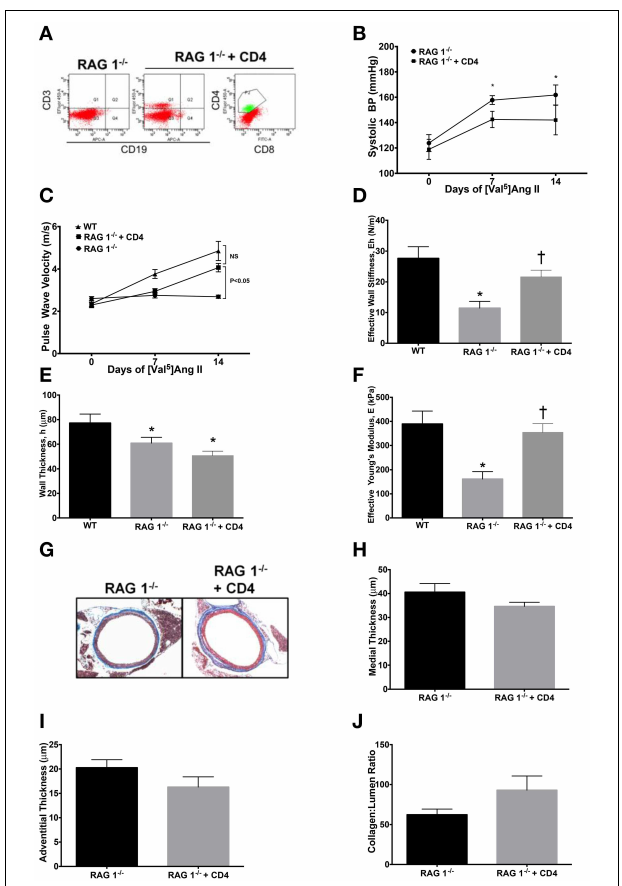
FIGURE 5 | Adoptive transfer of CD4 + T cells to RAG 1 − / − mice. CD4 + T cells were isolated from CD8 − / − mice and adoptively transferred to RAG 1 − / − mice. (A) Representative splenic flow cytometry 2 weeks after adoptive transfer of CD4 + T cells to RAG 1 − / − mice is displayed. Systolic blood pressure measurements by tail cuff (B) were made in RAG 1 − / − with adoptively transferred CD4 + T cells and stiffness was measured by pulse wave velocity (C) . Parameters in (D–F) are at 14 days of Ang II, including (D) effective wall stiffness, (E) wall thickness, and (F) effective Young’s modulus. Representative trichrome images (G) are presented of aortic cross-sections from RAG 1 − / − mice with adoptive transfer of CD4 + T cells followed by (H) medial and (I) adventitial thicknesses and (J) collagen:lumen ratio. * P < 0 . 05 vs. day 0 of RAG 1 − / − in (B) ; * P < 0 . 05 vs. WT in (D–F) ; † P < 0 . 05 vs. RAG 1 − / − . N = 6 –8. Data are means ±